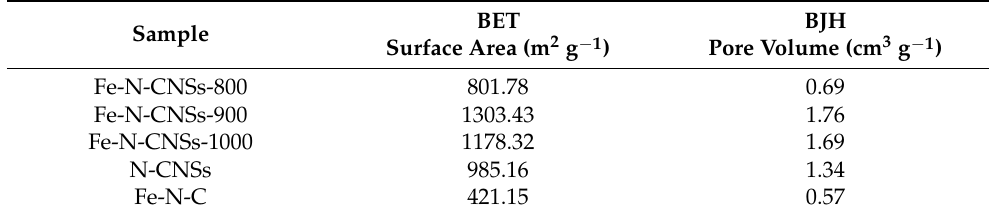
Table 3. BET surface area and BJH pore volume for Fe-N-CNSs-x (x = 800, 900 and 1000), N-CNSs and